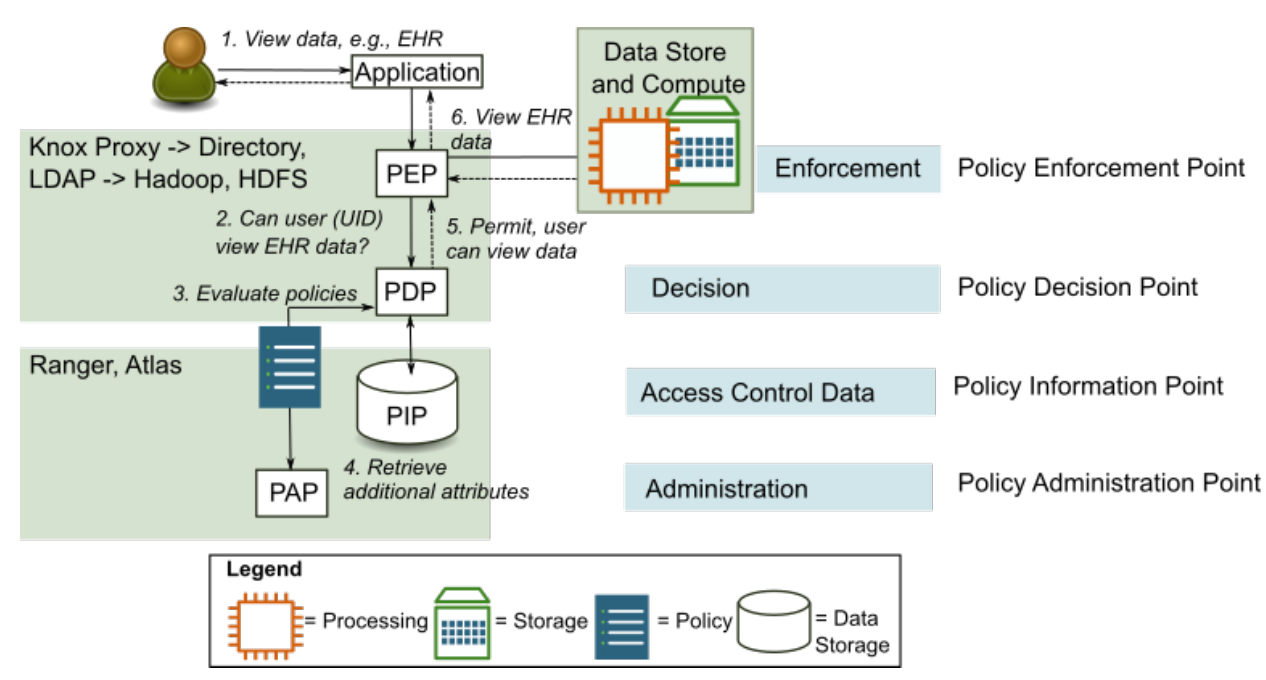
Figure 3. A standard architecture includes multiple points that contribute to the AC